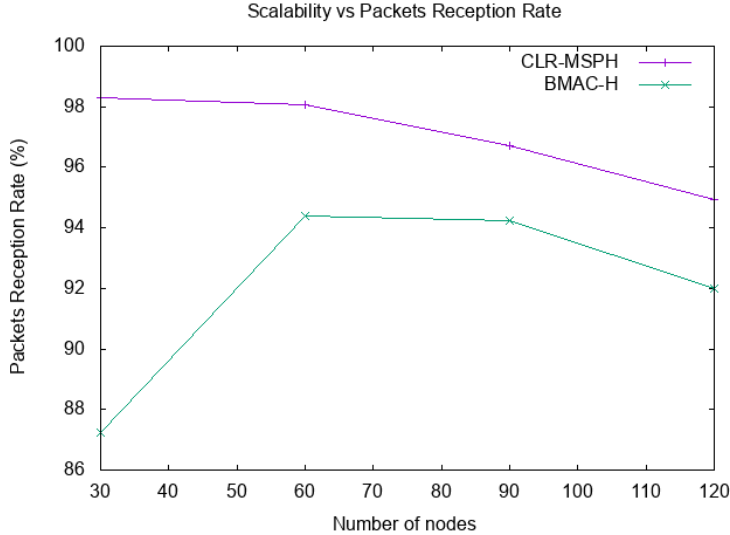
Figure 11. Scalability and Packets Reception Rate in each protocol. Table 5. Scalability and Packets Reception Rate.